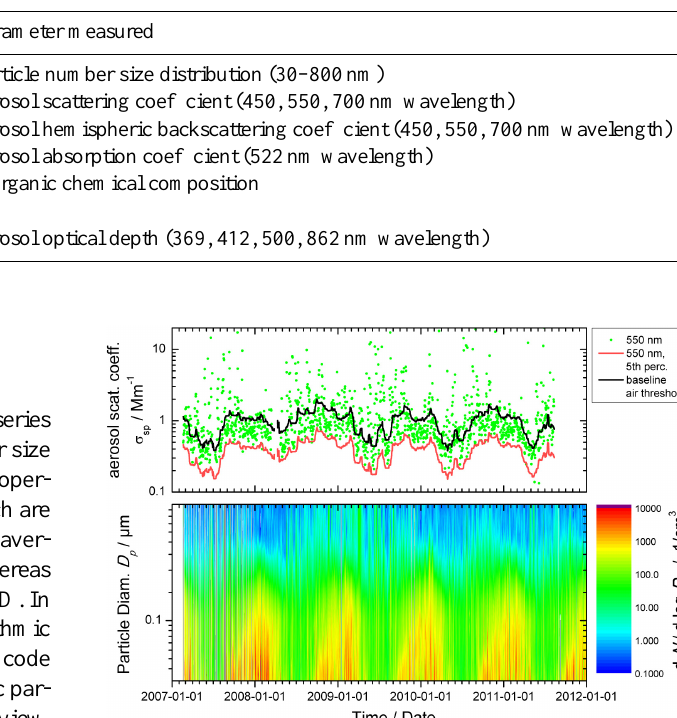
Table 1. Aerosol parameters observed at Troll and instruments used.